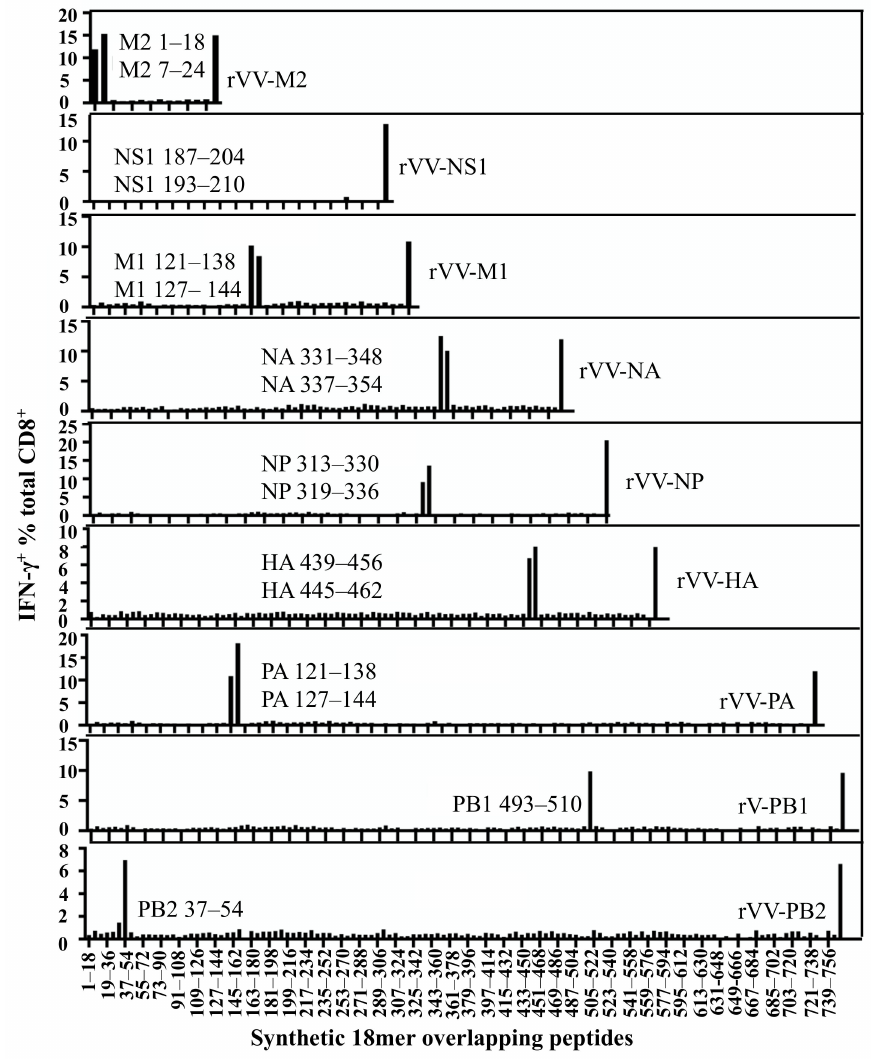
Figure 3. Identification of specific antigenic regions using synthetic 18mer overlapping peptides. The CD8 + T cell responses of individual IAV proteins were assessed with 18mer overlapping peptides covering the full sequences of M2, M1, NP, NS1, PB1, PB2, HA, NA, and PA in a standard ICS assay. In the same experiment, APCs infected by each rVV encoding individual IAV proteins were used as positive controls shown at the far right in each